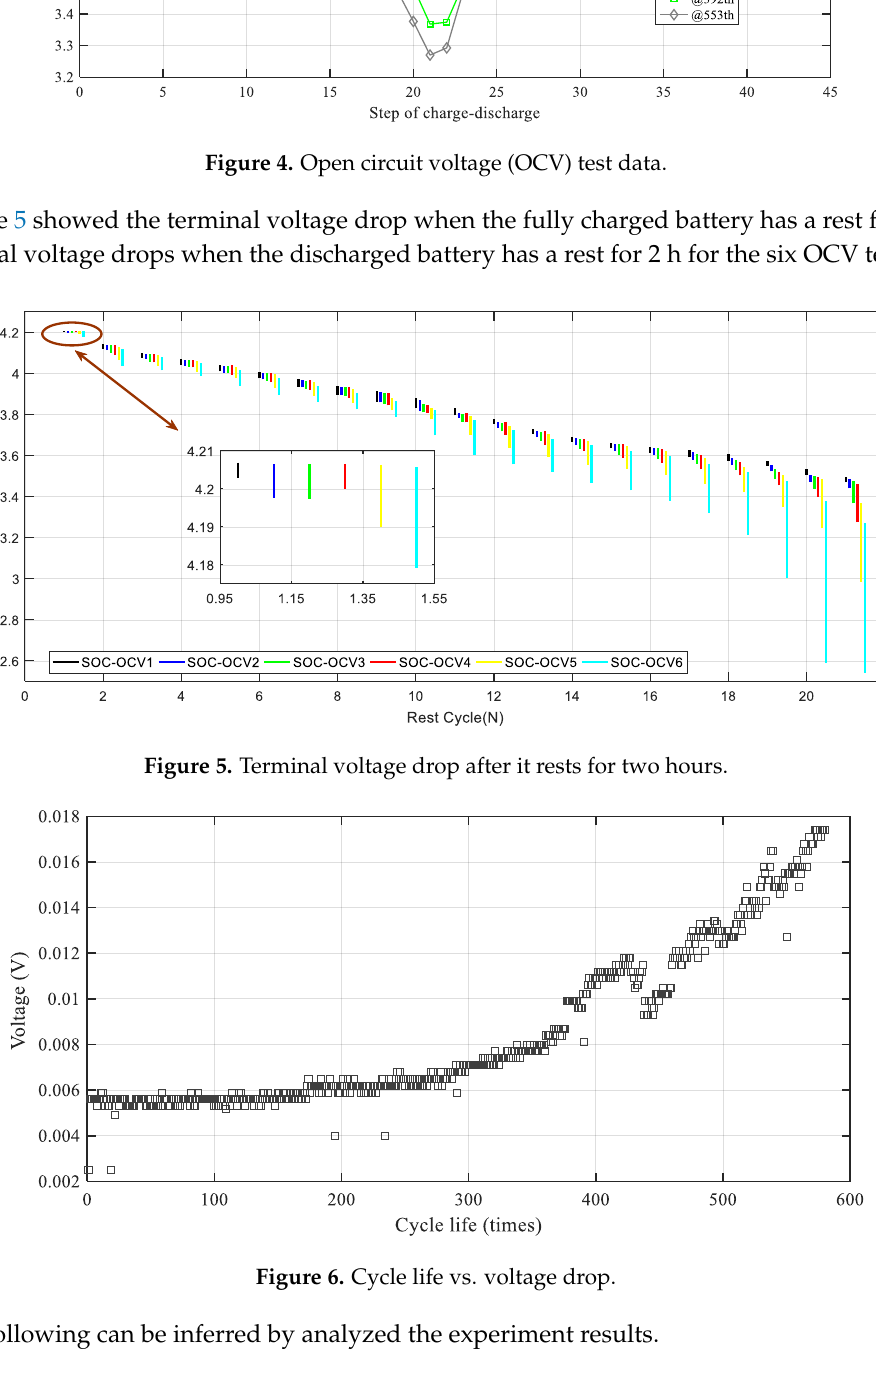
Figure 4. Open circuit voltage (OCV) test data.